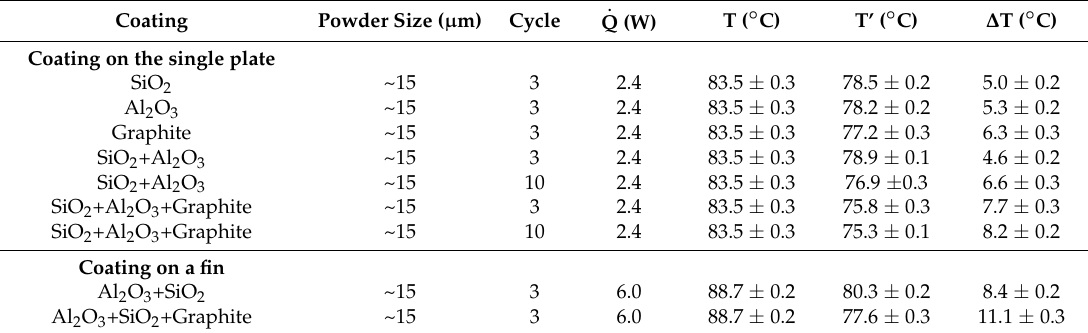
Table 7. Summary of dissipating effects for the coatings of different powders, all of a ~15 µ m size and all under the same heat input power complicate-shaped